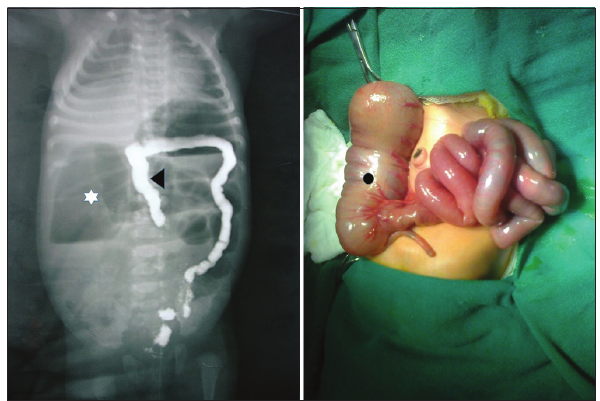
Figure 2: Contrast enema film showing dilated ascending colon with an air-fluid level (white star). It occupies most of the right half of abdomen and turns the right half of unused transverse colon on itself (black arrowhead). Intra‑operative photograph of the same patient, revealing a type IIIa atresia at hepatic flexure. Both cecum and ascending colon are not retroperitonized (Black